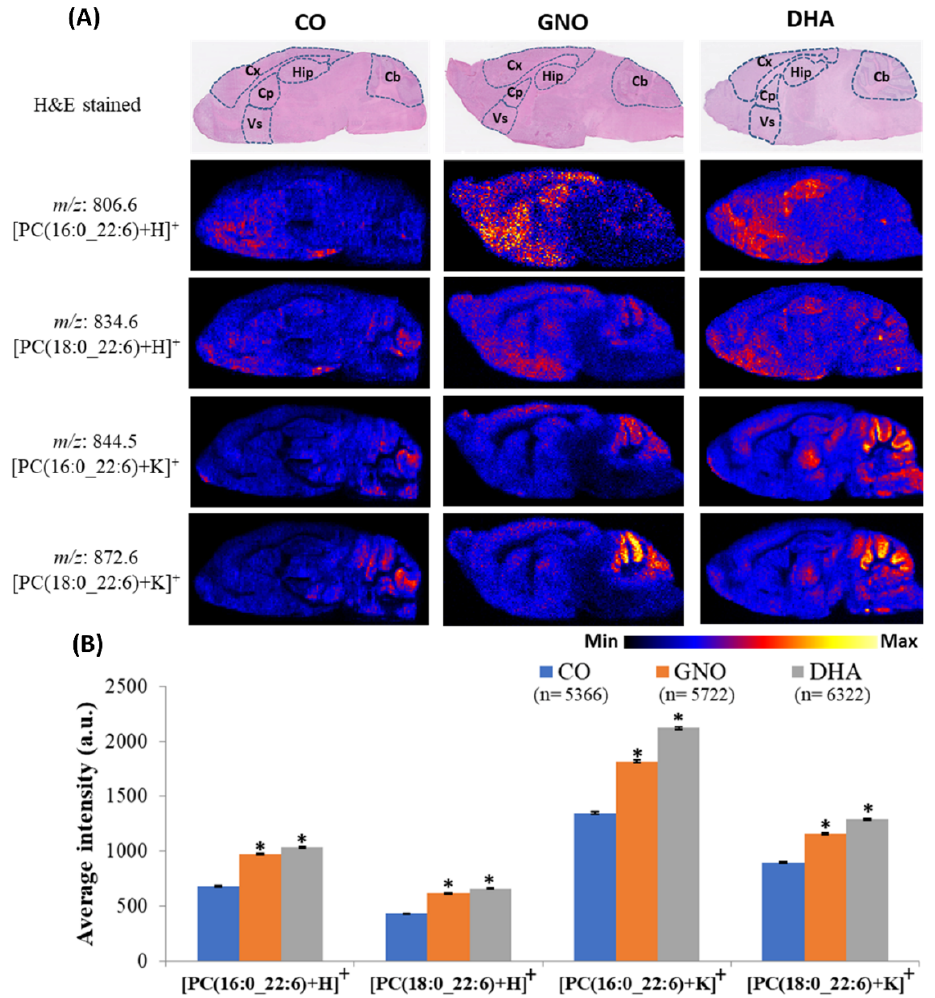
Figure 4. E ff ects of GNO or DHA treatment in the distribution levels of DHA-PCs in the brain of 28-week-old SAMP8 mice. ( A ) Representative ion images of DHA-PCs in the brain of CO, GNO, and DHA treated SAMP8 mice. Here Cb, Cx, Hip, Cp, and Vs indicate cerebellum, cerebral cortex, hippocampus, caudate putamen, and ventral striatum, respectively. ( B ) Average intensity of DHA-PCs in whole sagittal section of 28-week-old SAMP8 mice treated with CO, GNO and DHA. All values are represented as mean ± SEM. Here ‘a.u.’ indicates arbitrary unit, ‘*’ indicates p < 0.05 (one-way ANOVA with Tukey’s multiple comparison), and ‘ n ’ indicates number of pixels.